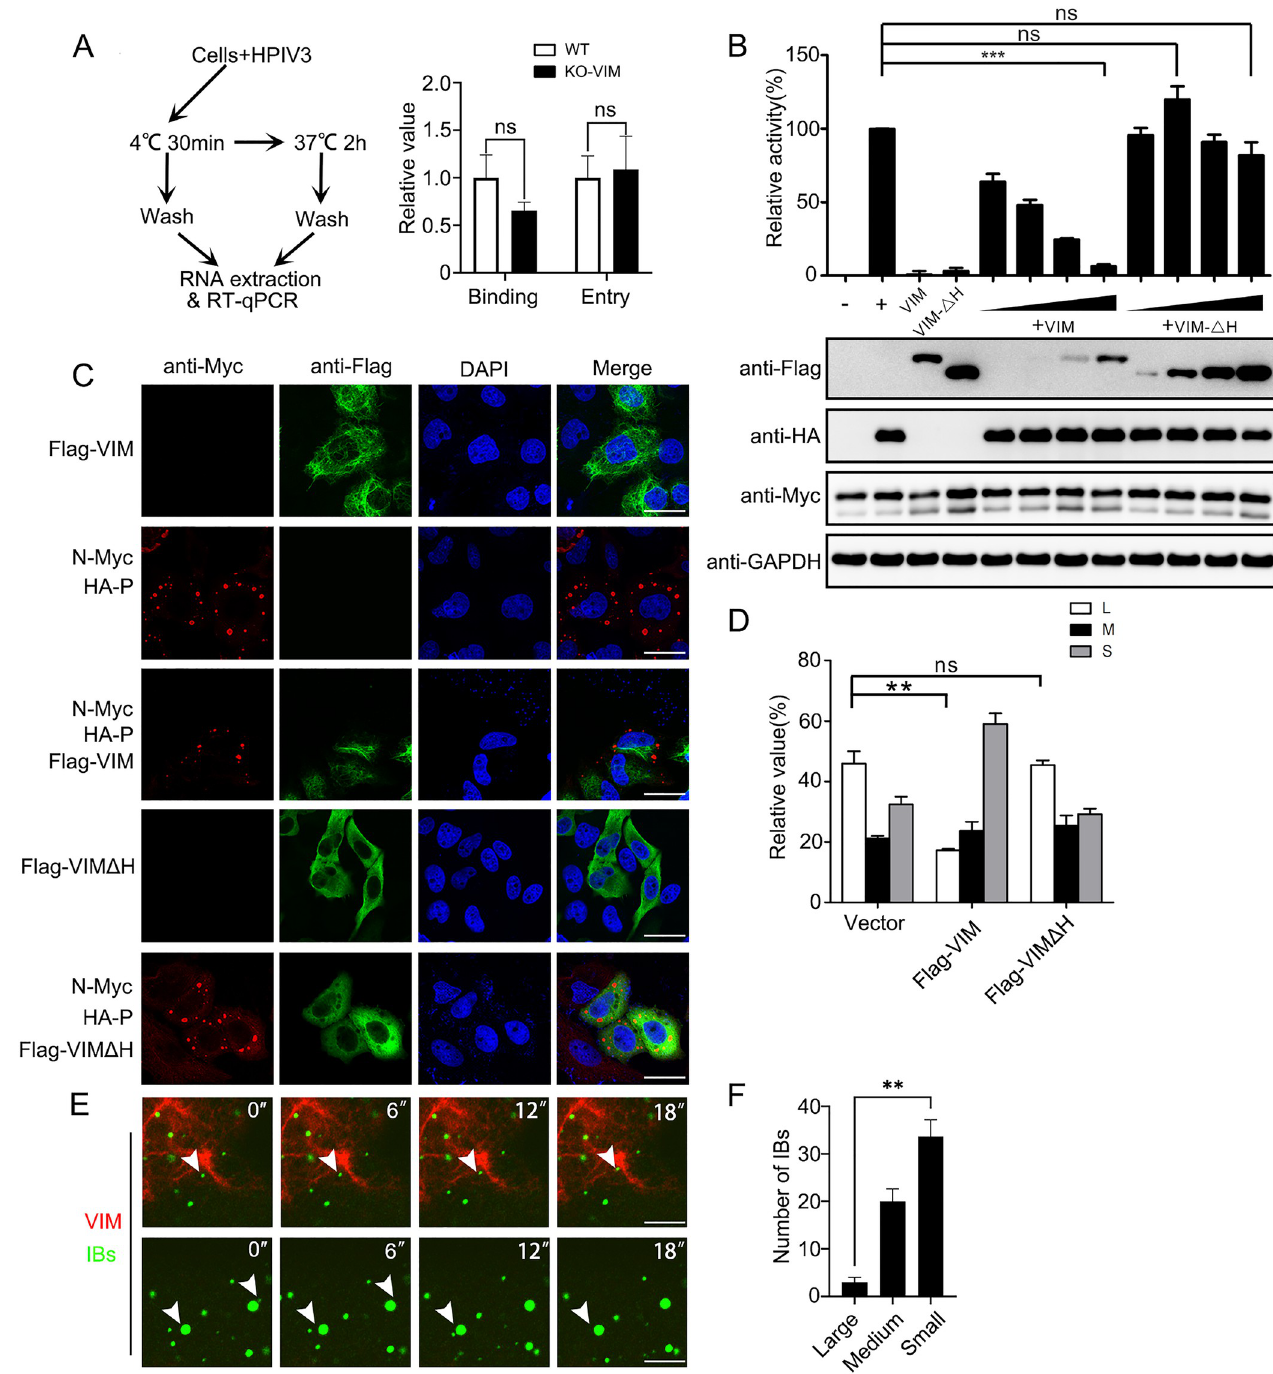
Fig 3. VIM suppresses HPIV3 replication and inhibits formation of HPIV3 IBs. (A) VIM did not impair the binding and entry of HPIV3. Schematic diagram of HPIV3 binding and entry assay in WT/VIM-KO A549 cells. Results for HPIV3 RNA levels were obtained using RT-qPCR, and the ratios of the relative changes normalized to the control group are shown. Three technical replicates were carried out in each analysis. At least three replicate experiments were performed. (B) VIM suppressed HPIV3 replication. An HPIV3 minigenome (MG) activity assay showed that VIM suppressed HPIV3 MG activity in a dose-dependent manner, but VIM Δ H did not. HeLa cells infected with VTF7-3 were transfected with plasmids encoding N, P, L, and viral MG. “-” means that only P plasmid was not transfected; “+” means that N, P, L, and MG plasmids were all transfected. VIM and VIM Δ H were both transfected in the “-” and “+” groups, to exclude their regulation of HPIV3 MG activity. Both protein expression and HPIV3 MG relative activity were detected. The activity of the “+” group was shown as 100% activity. (C) VIM suppressed the formation of HPIV3, but VIM Δ H did not. Flag–VIM and Flag–VIM Δ H were transfected alone or co-